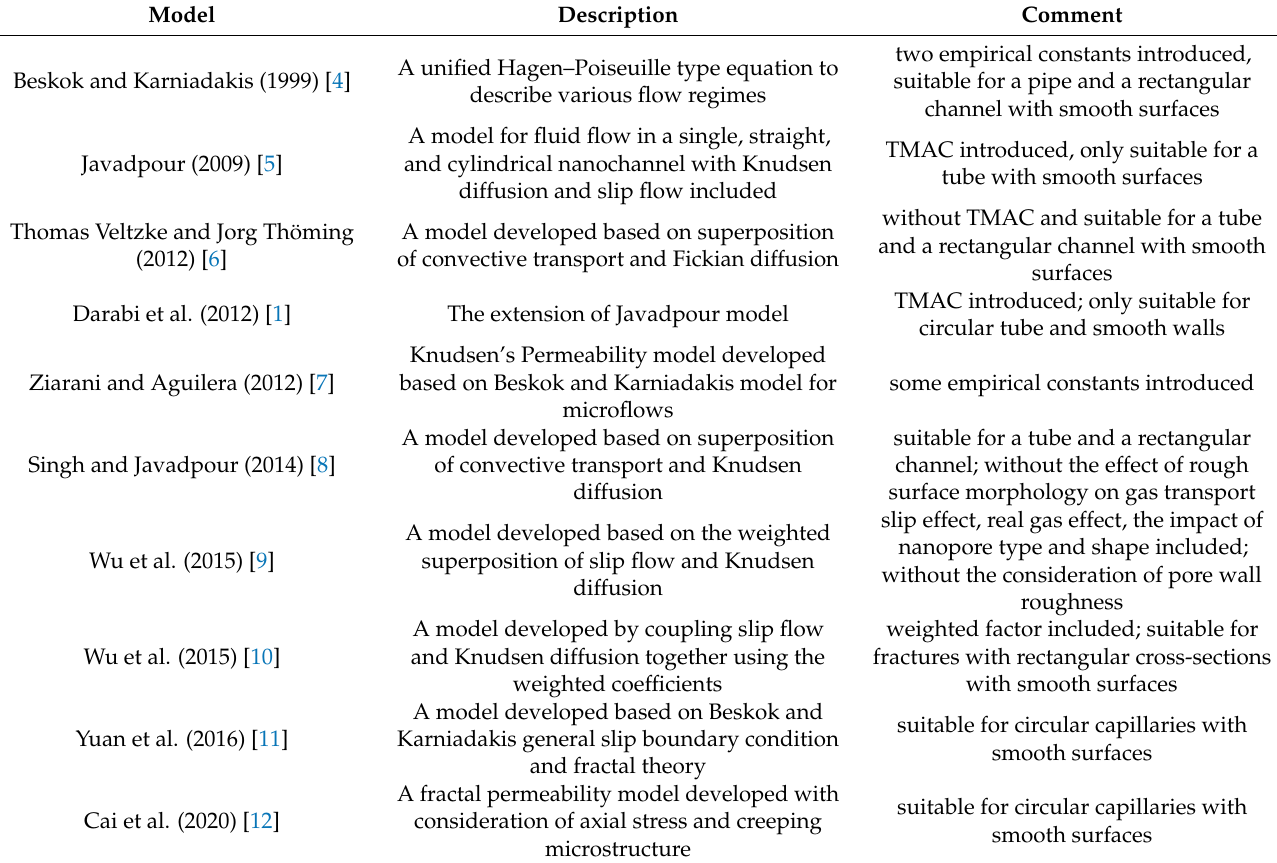
Table 1. A summary of different gas transport